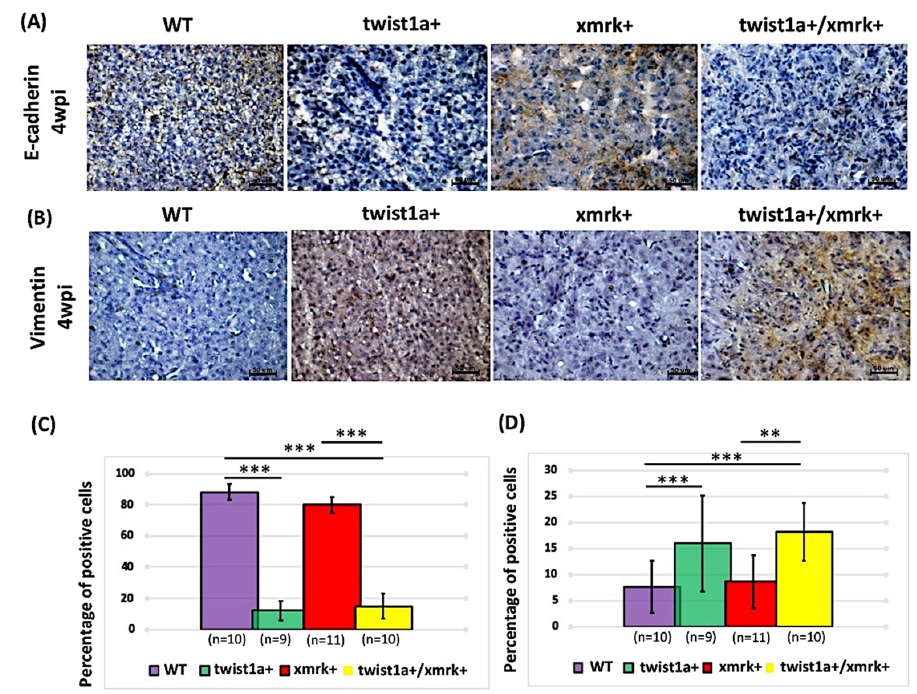
Figure 5. Assessment of E-cadherin and vimentin staining in instances of HCC progression in twist1a+/xmrk+ double transgenic zebrafish. Immunohistochemical staining was performed on liver paraffin sections from WT, twist1a+ , xmrk+ , and twist1a+/xmrk+ zebrafish at 4 wpi. Staining of markers of EMT activation: ( A ) E-cadherin and ( B ) vimentin. Scale bar: 50 µ m. Quantification of the percentage of cells testing positive for ( C ) E-cadherin and ( D ) vimentin. Differences among the variables were assessed using Student’s t -tests. Statistical significance: ** p < 0.01, *** p < 0.001.